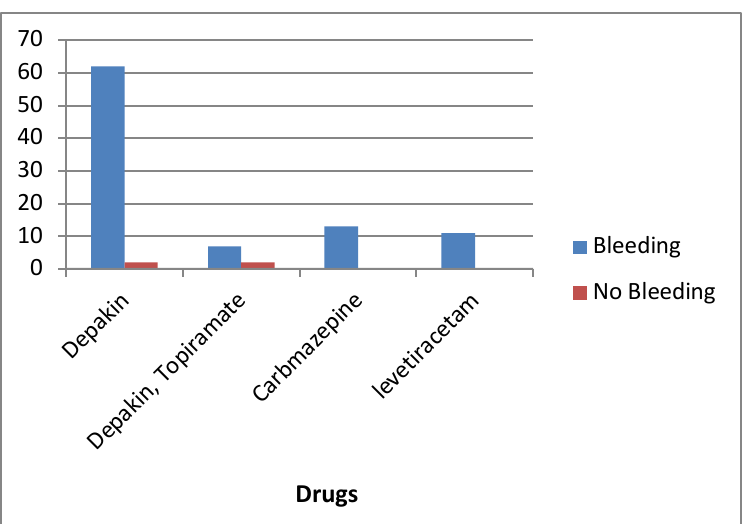
Figure (2) shows prevalence of bleeding according to the drug